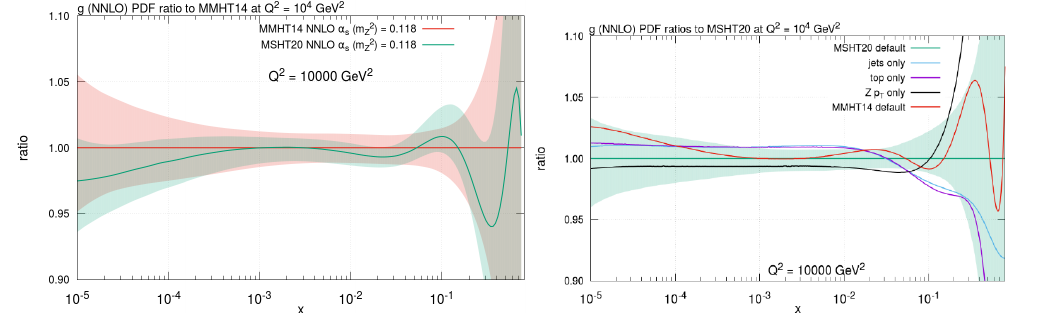
Figure 4: The MSHT20 gluon compared to MMHT14 (left); the different pulls on the MSHT20 gluon (right).